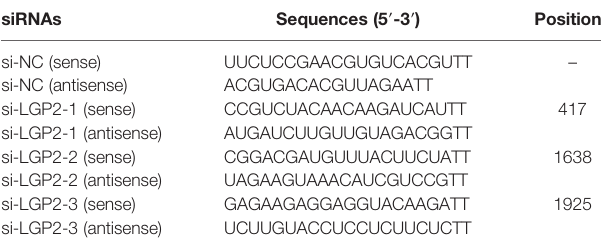
TABLE 1 | The sequences of